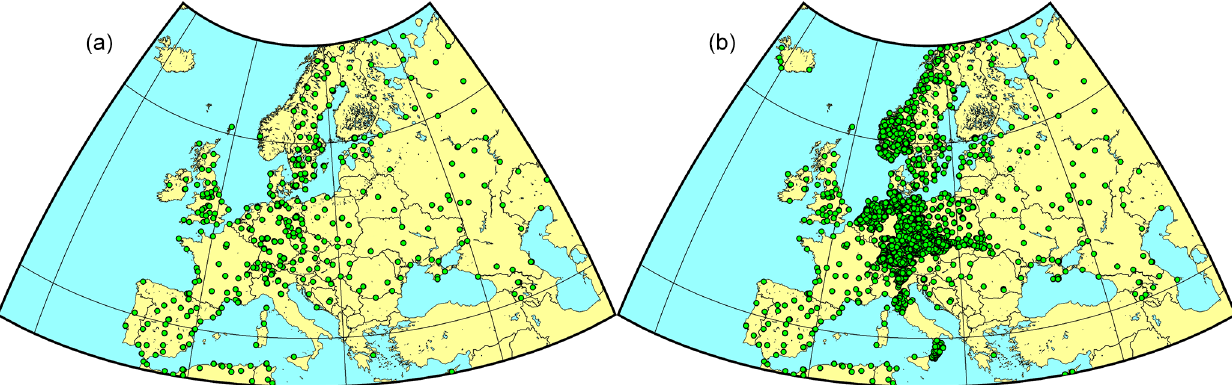
Figure 3. Map with the stations for daily temperature (a) and daily precipitation (b) that provide data for